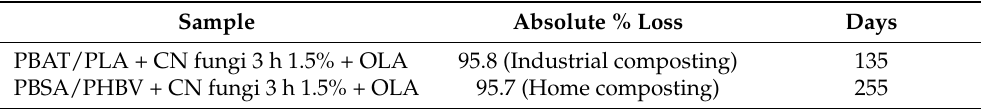
Table 11. Results of biodegradability